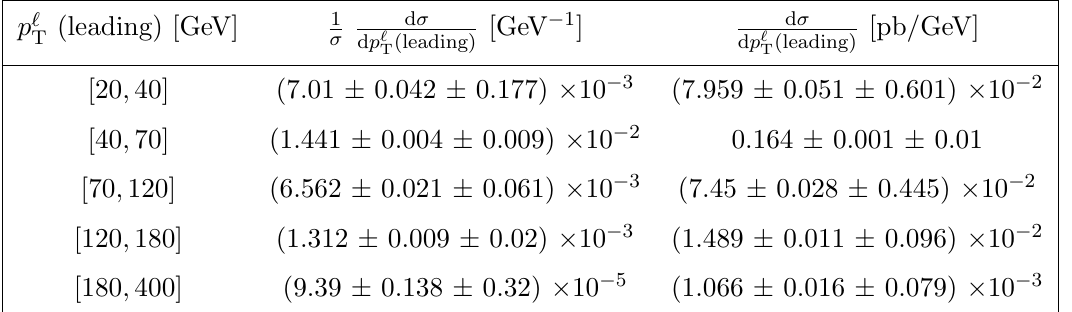
Table 31 . The measured di(cid:11)erential cross section and bin boundaries for each bin of the normalized and absolute measurements of the tt di(cid:11)erential cross section at particle level in the (cid:12)ducial phase space as a function of p ‘ (leading) are T